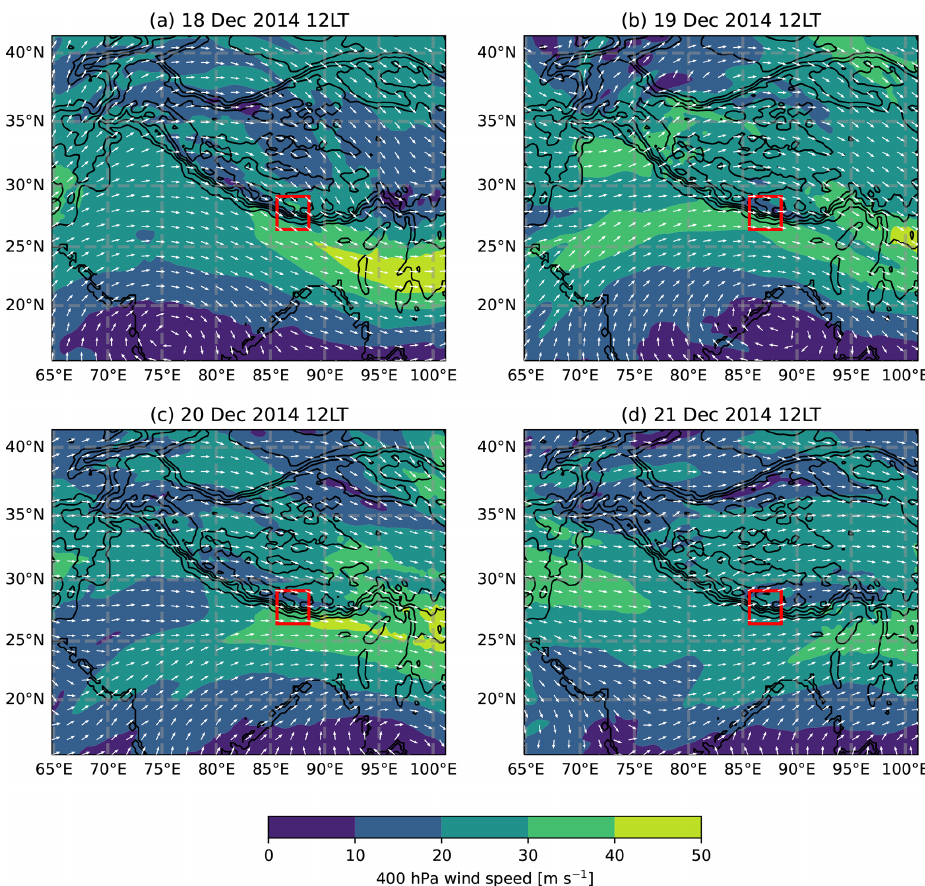
Figure 4. The 400hPa wind speed (shading) and direction (white vectors) in the d01 domain at 12:00LT (noon) on 18–21 December 2014. Black solid lines show the WRF simulation topography (ma.s.l.) with a contour interval of 1000m. The red boxes mark the location of the inner domain